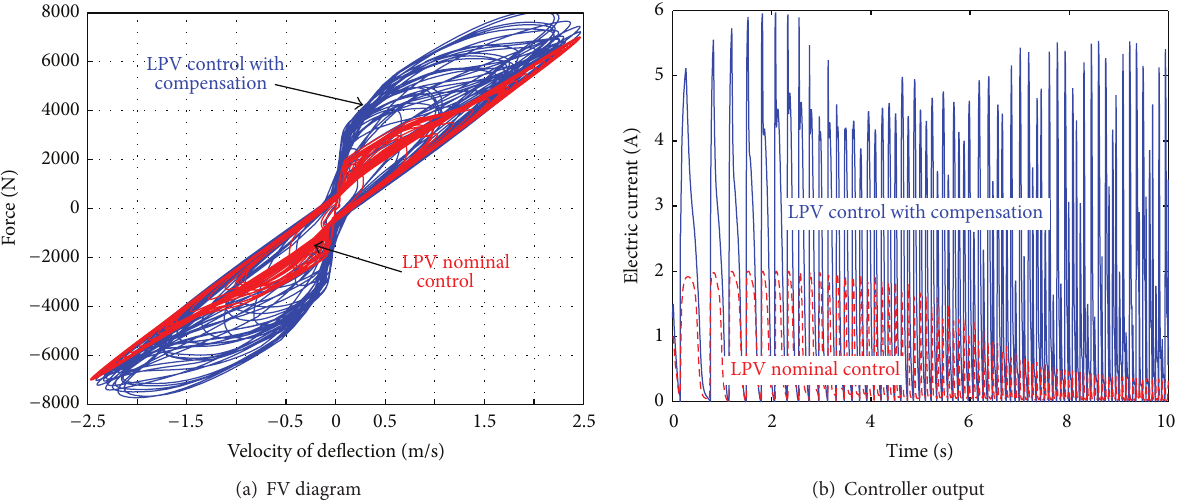
Figure 13: (a) Semiactive damping force in the front-right corner with and without fault compensation and (b) the corresponding controller